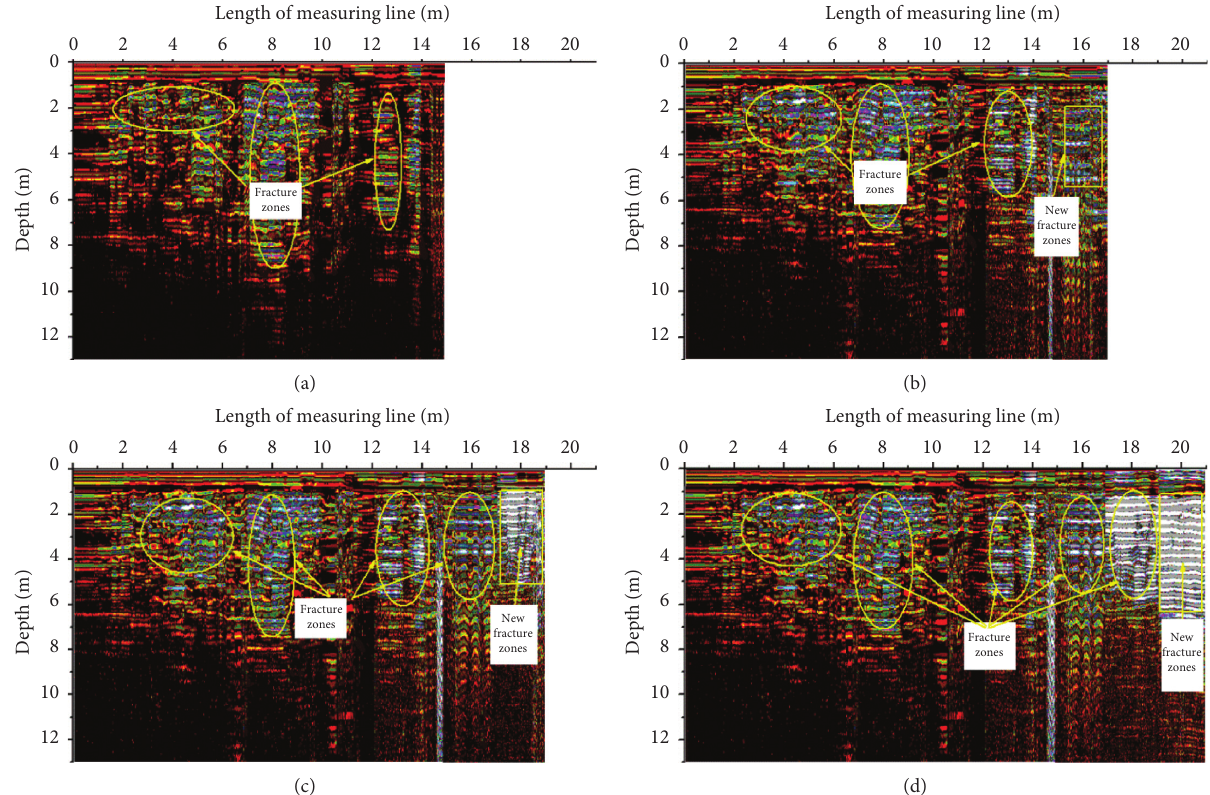
Figure 14: Floor test results. (a) Before excavation. (b) First excavation. (c) Second excavation. (d) Third